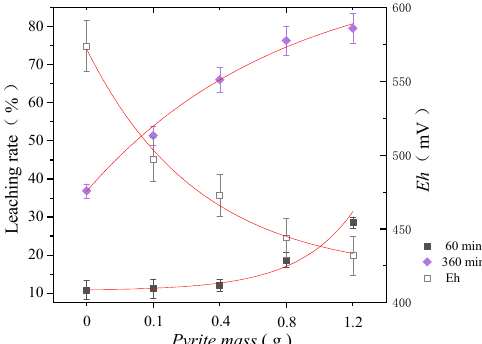
Figure 2. Uranium leaching rate versus the quantity of FeS 2 added.